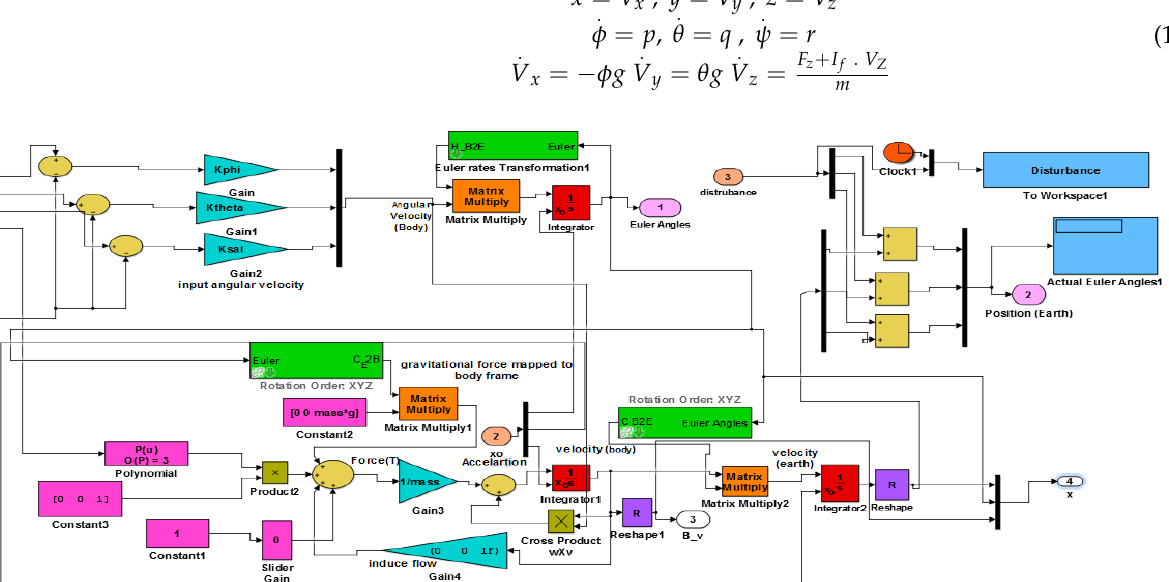
Figure 3. X3D Quadrotor Nonlinear Simulink model.